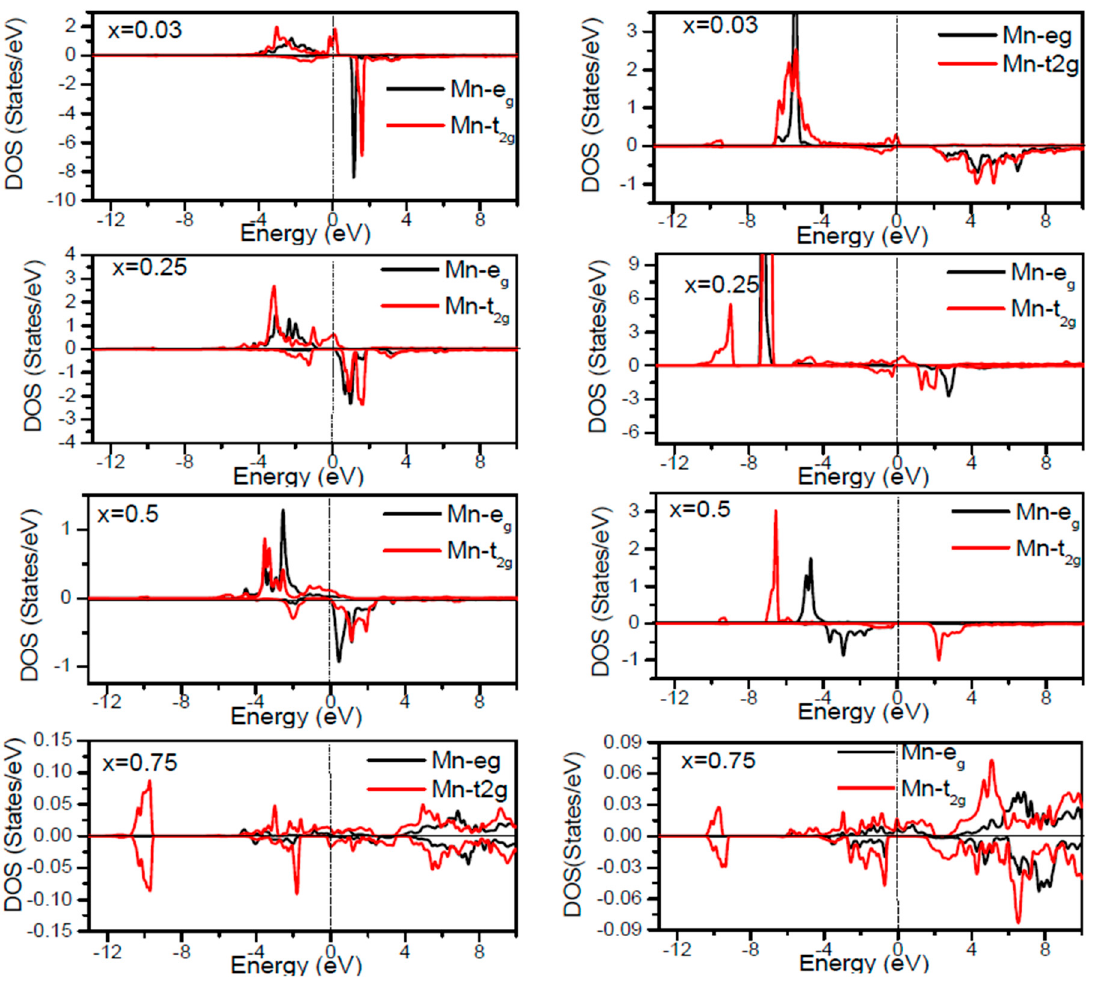
Figure 7. Computed t 2g and e g -DOS of the Mn atom in the Ga 1 − x Mn x P ( x = 0.03, 0.25, 0.5, and 0.75) alloys for spin up and spin down. The left panel shows the GGA results and right panel denotes GGA + U results. The vertical dash line denotes the Fermi level.